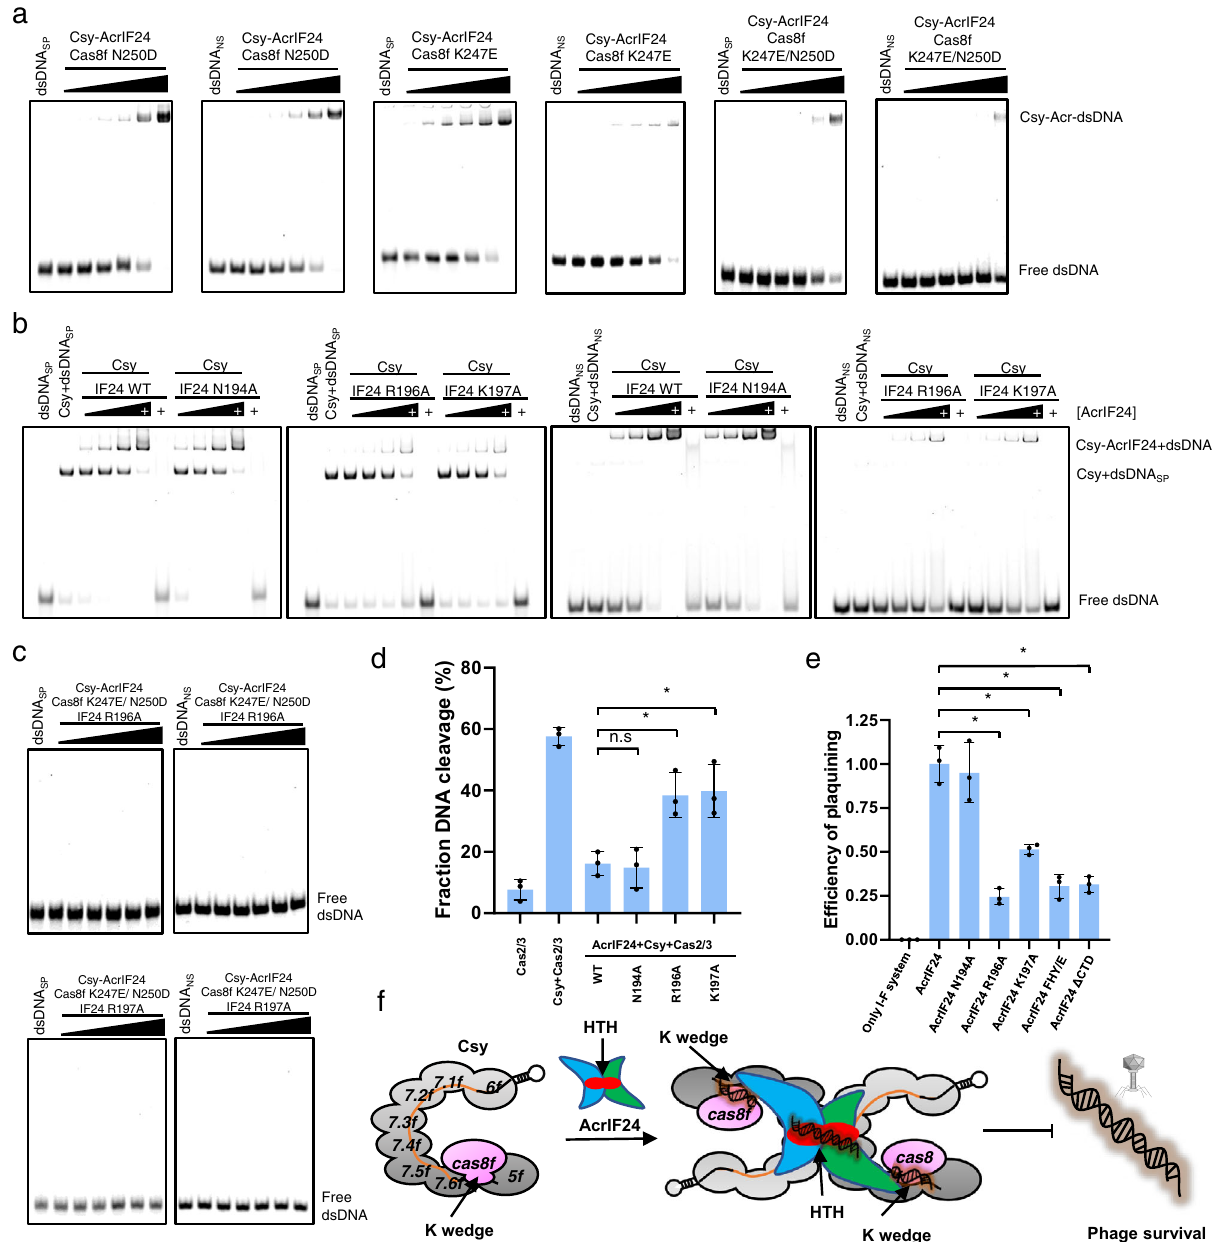
Fig. 7 Structural elements involved in dsDNA binding by the Csy-AcrIF24 complex. a EMSA used to test the non-speci fi c DNA binding ability of Csy- AcrIF24 with mutations in the PAM recognition loop of Cas8f using dsDNA SP and dsDNA NS . Reactions were performed as in Fig. 5c. Please see the right panels of Figs. 5c, d for WT controls of the experiments using dsDNA SP and dsDNA NS , respectively. b EMSA used to test the induction of non-speci fi c DNA binding by AcrIF24 or its mutants using dsDNA SP and dsDNA NS . Reactions were performed as in Fig. 5a. c EMSA used to test the non-speci fi c DNA binding ability of Csy-AcrIF24 with mutations both in AcrIF24 and Csy using dsDNA SP and dsDNA NS . Reactions were performed as in Fig. 5c. Please see the right panels of Figs. 5c, d for WT controls of the experiments using dsDNA SP and dsDNA NS , respectively. d Mutations impairing the induction of non-speci fi c DNA binding of AcrIF24 decreased its capacity of inhibition in the in vitro cleavage activity assay. Reactions were performed as in Fig. 1a except that the concentrations of AcrIF24 or its mutants were set as 0.16 μ M. Data are presented as mean values ± SD; n = 3. Two-sided t test was performed. The “ * “ indicates that there is a signi fi cant difference between the quantitative data ( P < 0.05). * P = 0.0098, 0.0125 (left to right). n.s, not signi fi cant , P = 0.7685. e Phage plaque assay veri fi ed that mutations impairing the induction of non-speci fi c DNA binding of AcrIF24 decreased its capacity of inhibition of the type I-F system in vivo. Data are presented as mean values± SD; n = 3. A two-sided t test was performed. The “ * “ indicates that there is a signi fi cant difference between the quantitative data ( P < 0.05). * P = 0.0003, 0.0015, 0.0006, 0.0005 (left to right). f Schematic illustration of working mechanisms of AcrIF24 on the inhibition of type I-F CRISPR-Cas system. Direct interaction with Csy and induction of its non-speci fi c DNA binding both contribute to the inhibition by